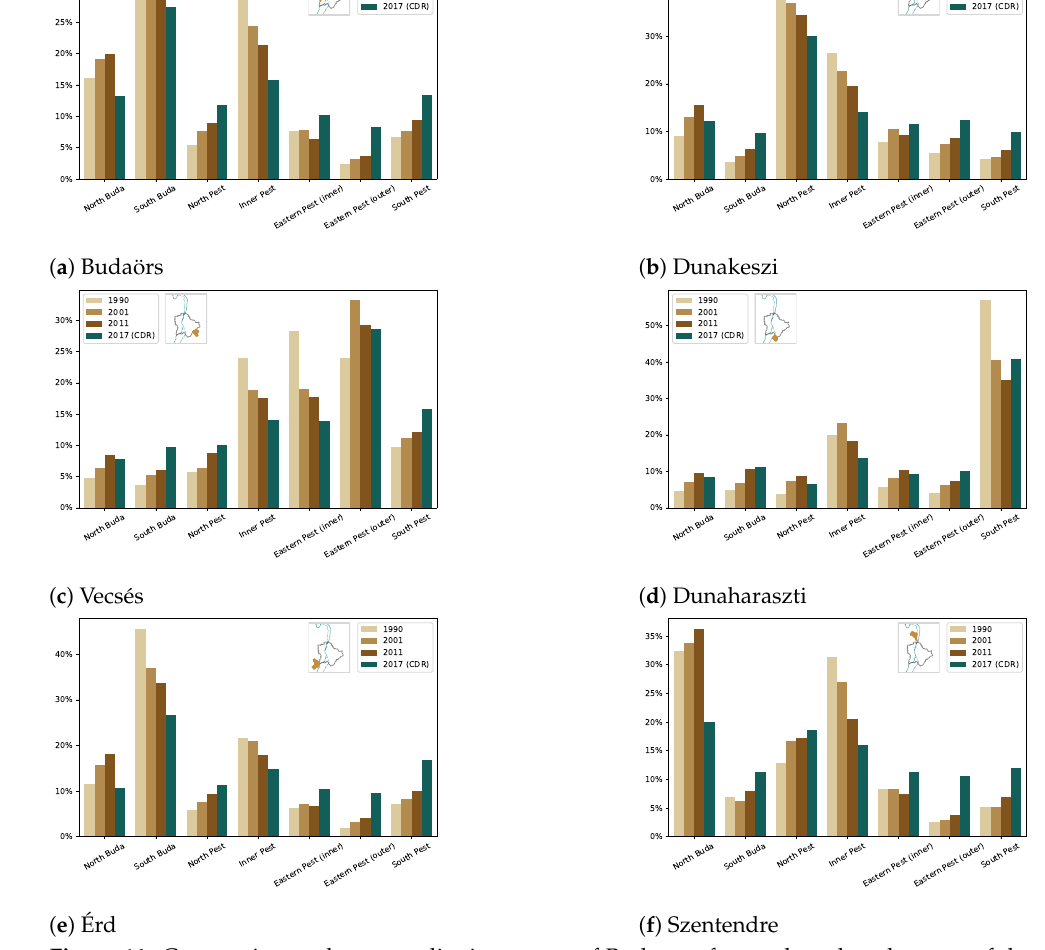
Figure 14. Commuting to the seven district groups of Budapest from selected settlements of the agglomeration, comparing census (1990, 2001, and 2011) and mobile network data. Next to the legends, the location of the settlements in question is displayed on a